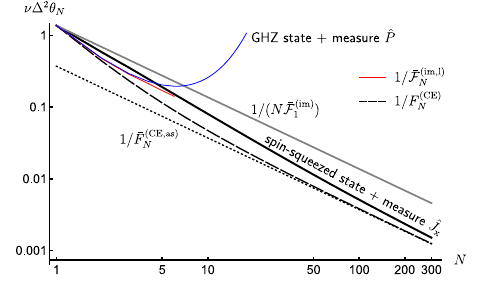
Fig. 6 | Attaining the optimal SS of precision in presence of measurement imperfections and local unitary control. The thick solid black line depicts the MSE in estimating phase θ from an imperfect measurement of the angular momentum operator ^ J x , while the N qubit probes are prepared in a one-axis spin- squeezed state 57 , optimised by local control (see Methods). The noisy detection channel corresponds to an asymmetric bit- fl ip map with probabilities p =0 : 95 and q =0 : 9. The dotted black line denotes the asymptotic CE bound with (cid:2) F ð CE,as Þ N given by Eq. (24), while the thin red solid line is the exact achievable precision 1 = (cid:2) F ð im,l Þ N , which we compute numerically up to N =6 by brute-force heuristic methods. The dashedblacklinecorrespondsto1 = F ð CE Þ N inEq.(21)applicableinabsenceofcontrol = 1 ).Atsmall N ( ≲ 4),theultimateprecisioncanbeattainedbyperforming ( 8 ‘ : V ð ‘ Þ ~ ϕ ‘ (imperfect) parity measurements with input GHZ states (thin blue line). For com- parison, we also include the optimal precision attained by uncorrelated probe states, 1 = ð N (cid:2) F ð im Þ 1 Þ , (solid